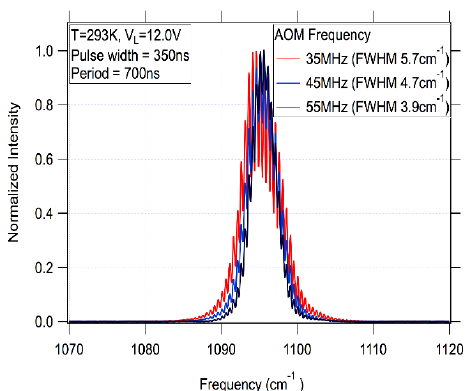
Figure 7. Spectral measurements at three AOM drive frequencies, keeping laser wavelength constant by adjusting the back reflecting mirror tilt.